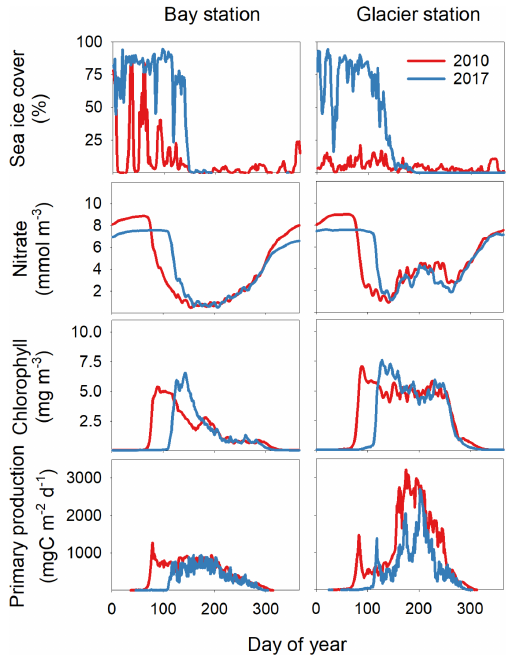
Figure 5. Sea ice cover (%), average nitrate concentration at 0–30m (mmolm − 3 ), average Chl a concentration at 0–30m (mgm − 3 ), and primary production (mgCm − 2 d − 1 ) at a station in the open bay (bay station) and at a station close to the glacier (glacier station) (Fig. 1) in 2010 and